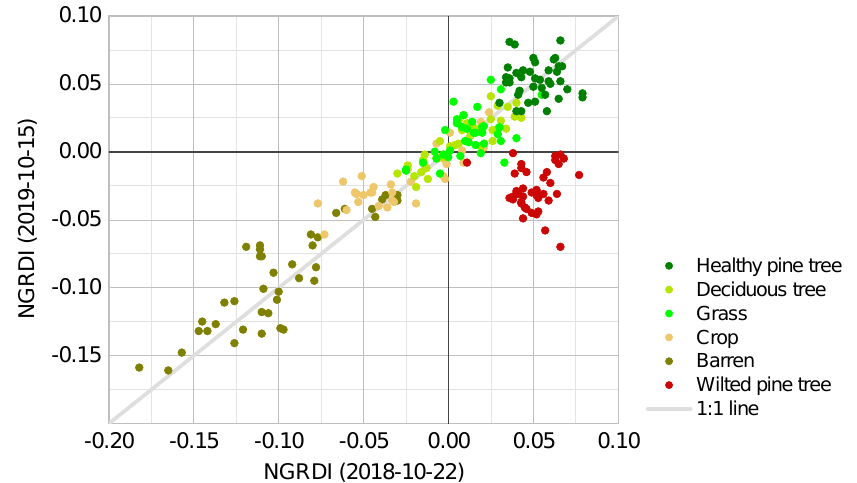
Figure 6. Scatter plot derived using the NGRDI observations for pixels belongs to typical land (or surface) cover types in 2018 and 2019. The wilted pine trees were caused by the PWD in 2019, and there were no land (or surface) cover change for the rest pixels between the two